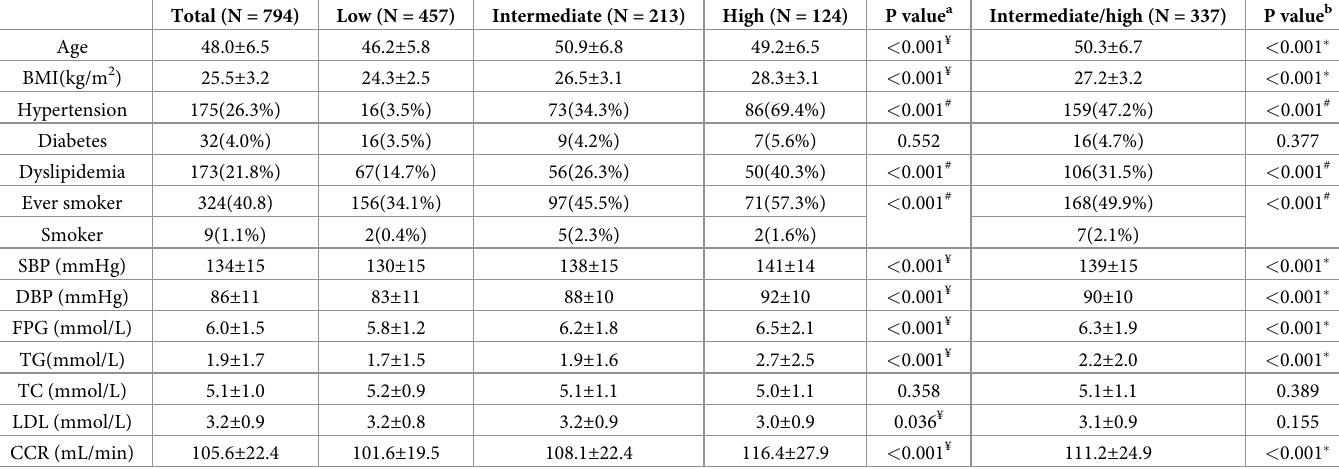
Table 1. Characteristics of study population grouped by OSA risk assessed by STOP-BANG scores.